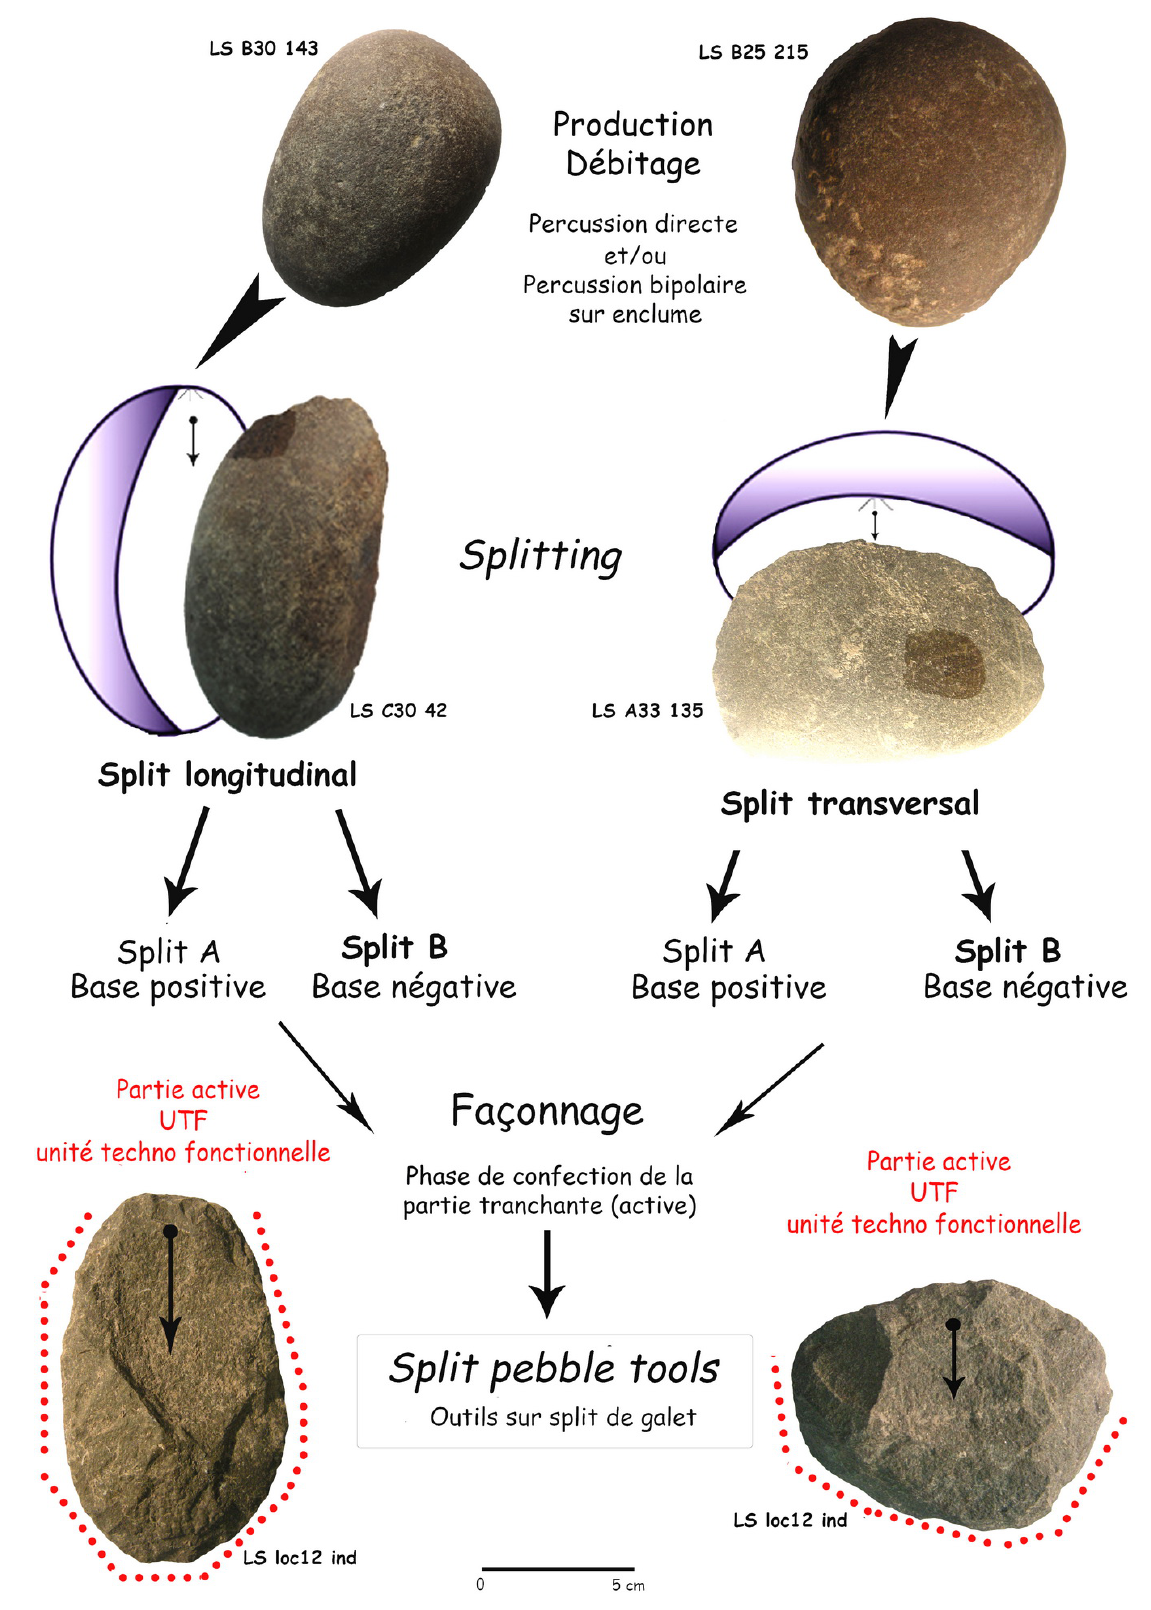
Figure 14. Schéma synthétique des différentes étapes dans la fracturation en split d’un galet. Figure 14. Synthetic sketch of the different steps of a split pebble